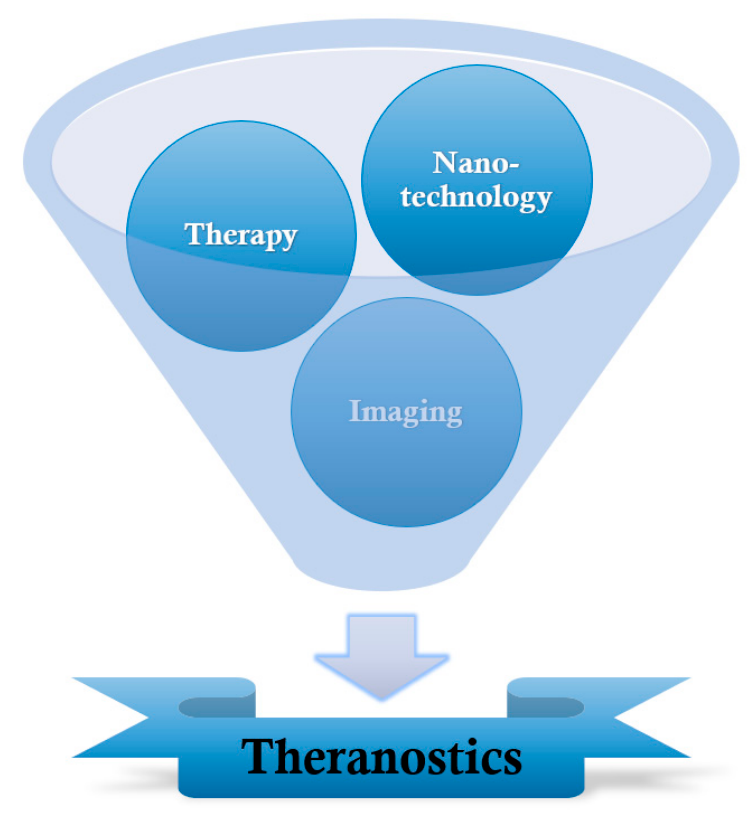
Figure 15. Schematic representation of theranostics.